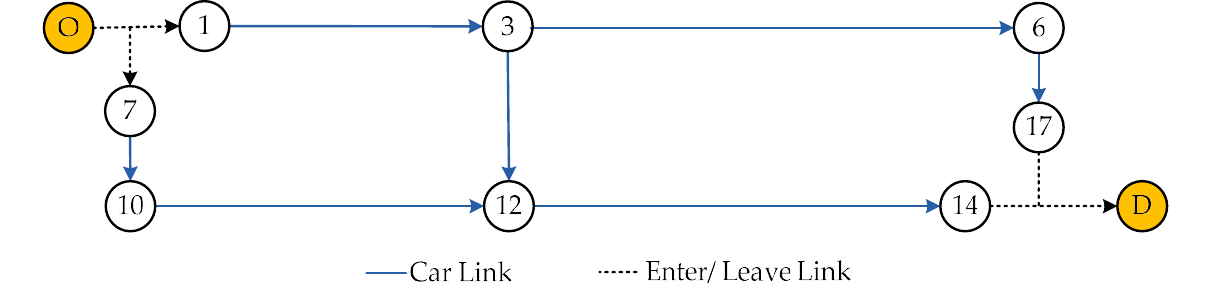
Figure 7. The routes of the car network.